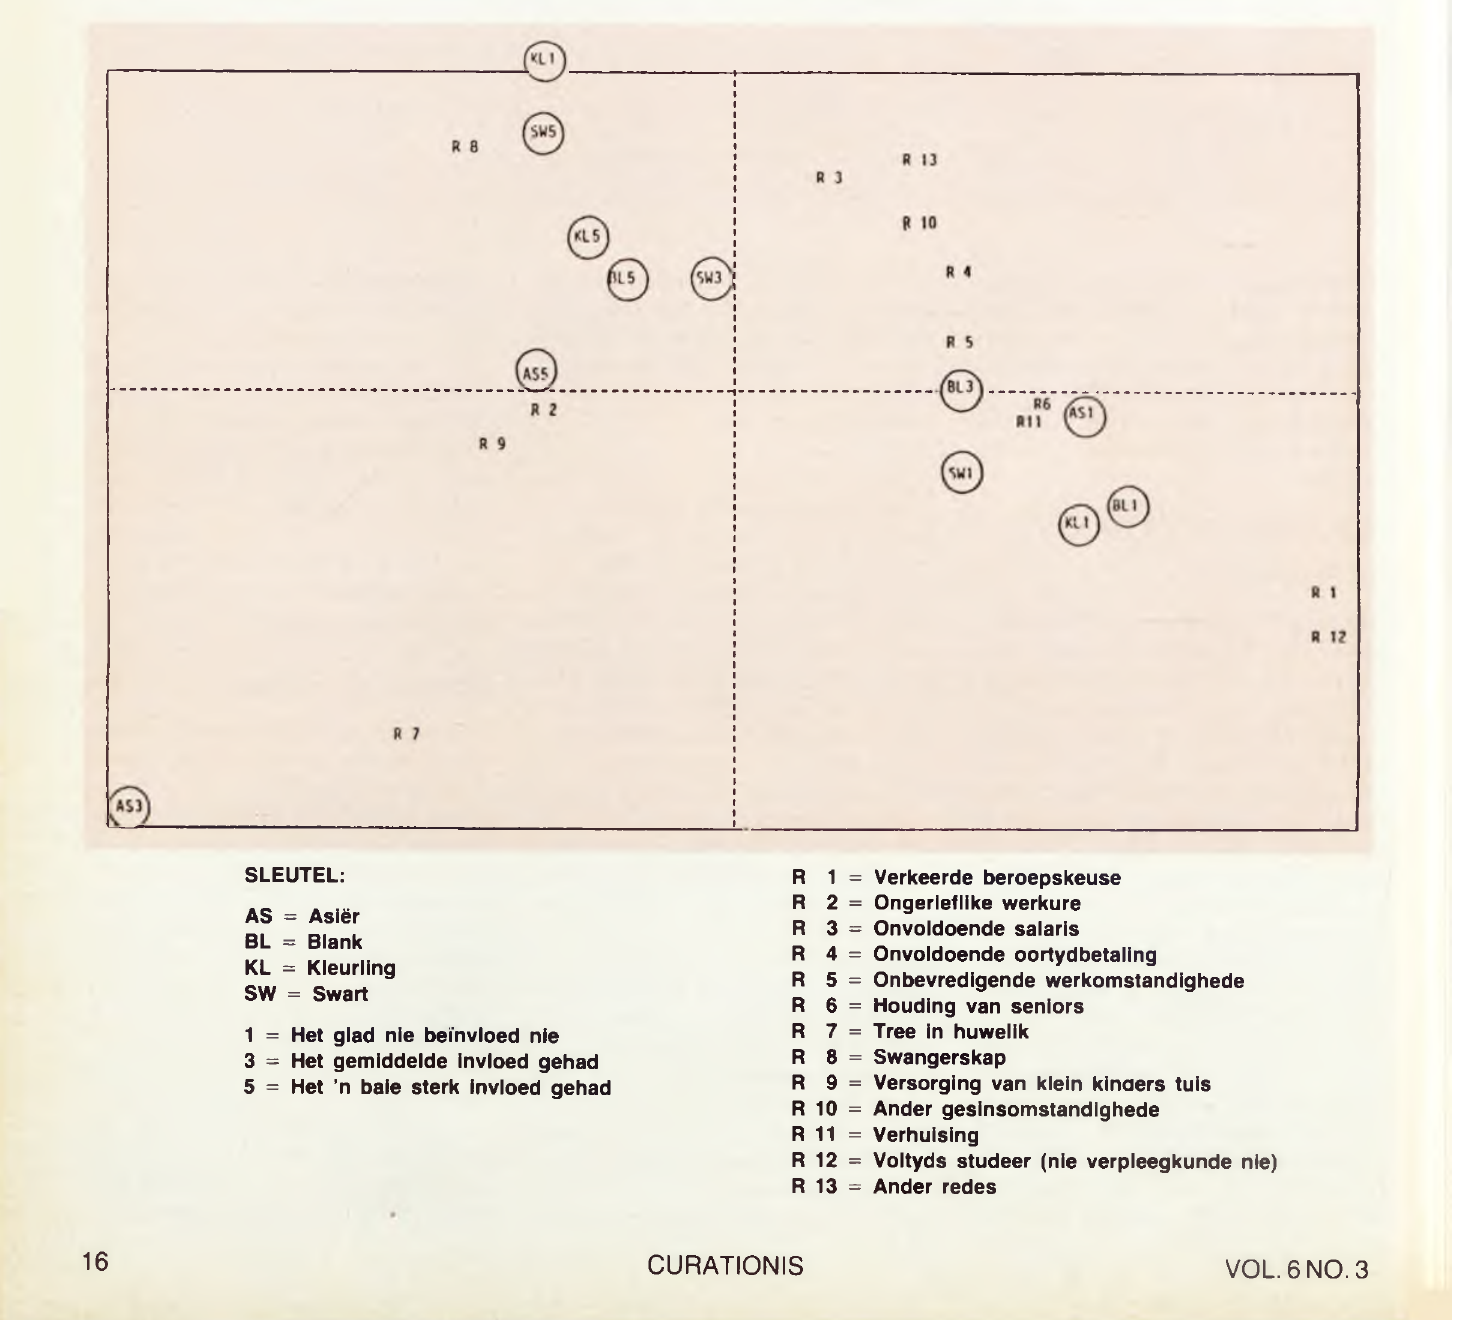
Figuur 2: Redes waarom respondente bedank, volgens